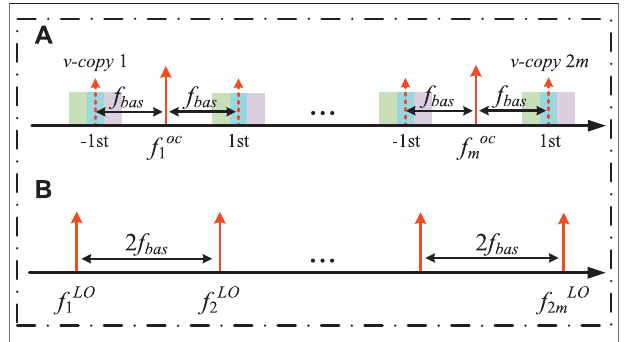
FIGURE 3 | Spectra diagrams of (A) the modulated optical carriers s after double sideband modulation and (B) local oscillators generated from ultra- fl at optical comb generator